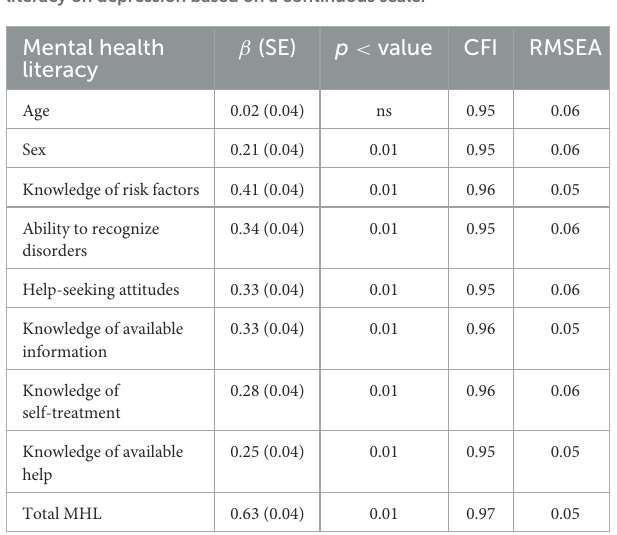
TABLE 3 Multivariable regression model of the unique influence of different domains of mental health literacy on depression based on a continuous